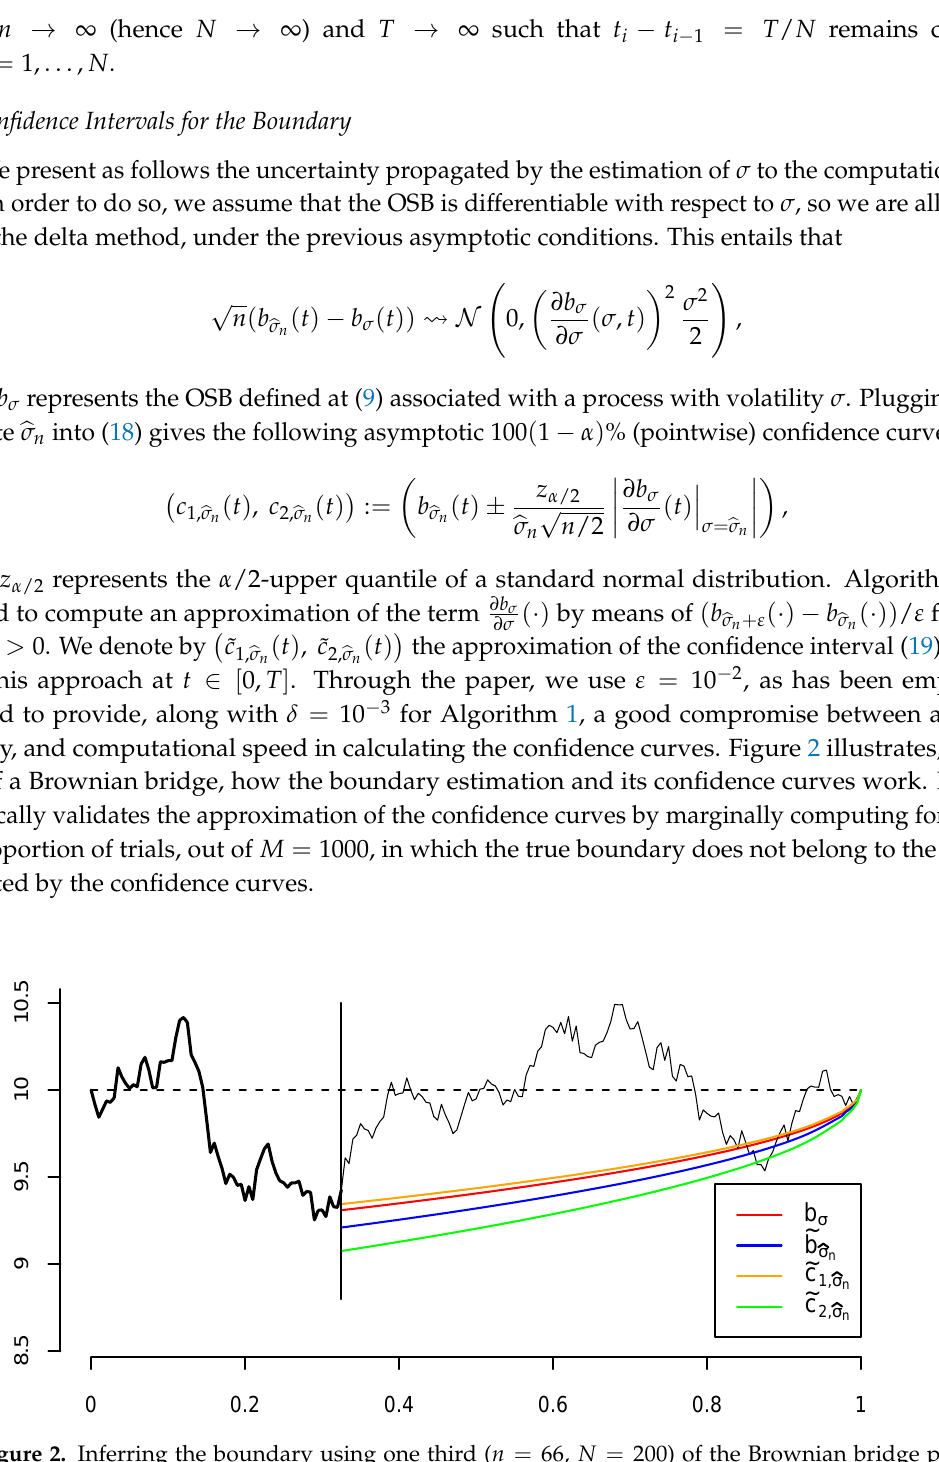
(orange curve), (cid:98) σ n